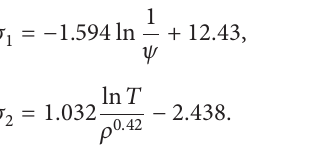
of ionization of hydrogen and helium. Figure 1 shows the variation of the central temperature as a function of radius for different mass ranges. If the critical temperature for thermonuclear reactions is around 3 × 10 6 K, we can roughly estimate the critical mass for the main sequence as ∼ 0.085 𝑀 ⊙